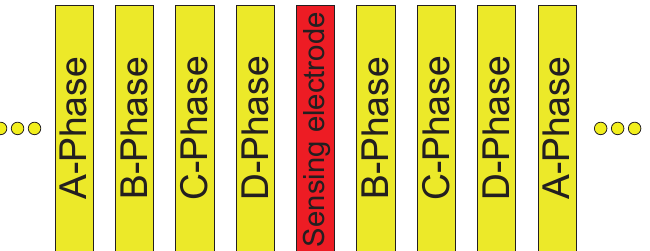
Figure 11. Arrangement of the stator electrodes. The stator electrodes are connected in 4 phases, such that the 4 phases appear repeatedly in the same order. The sensing electrode is electrically independent and is not connected to the 4-phase. The phase that was originally assigned to the sensing electrode is skipped.